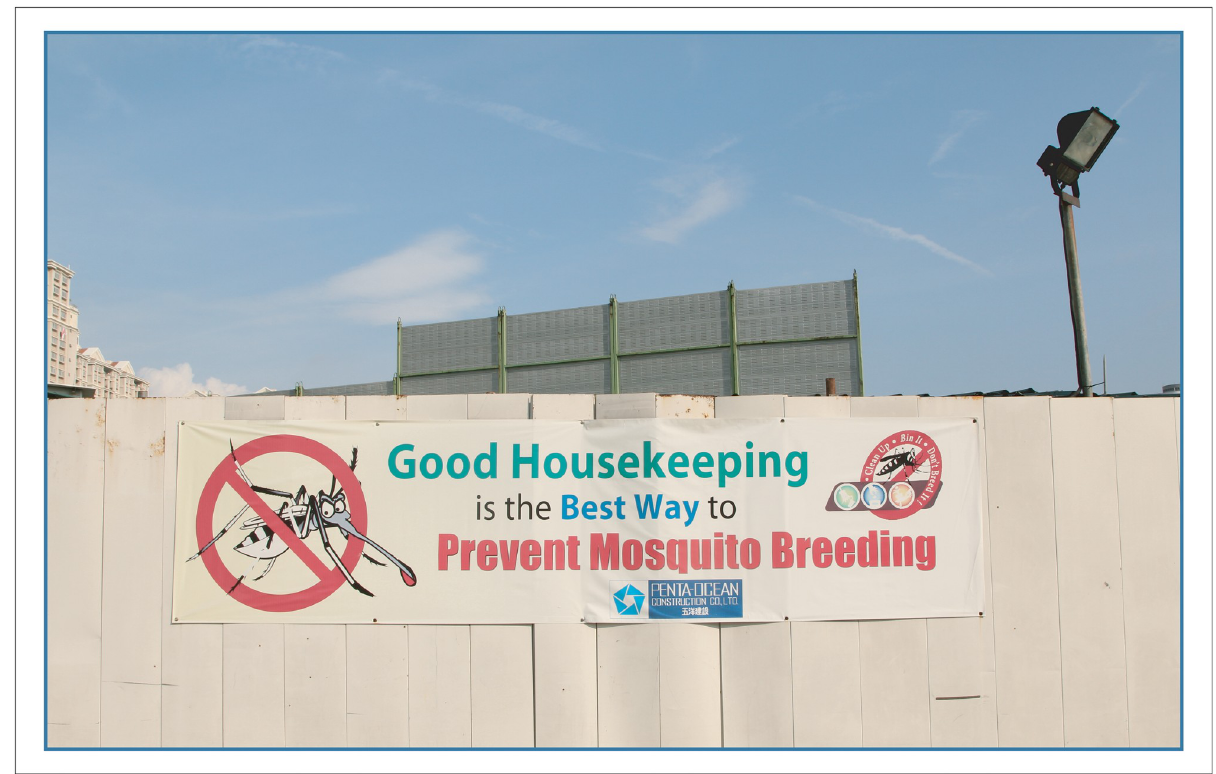
Fig 4. Banners at construction sites to encourage good housekeeping to reduce Aedes